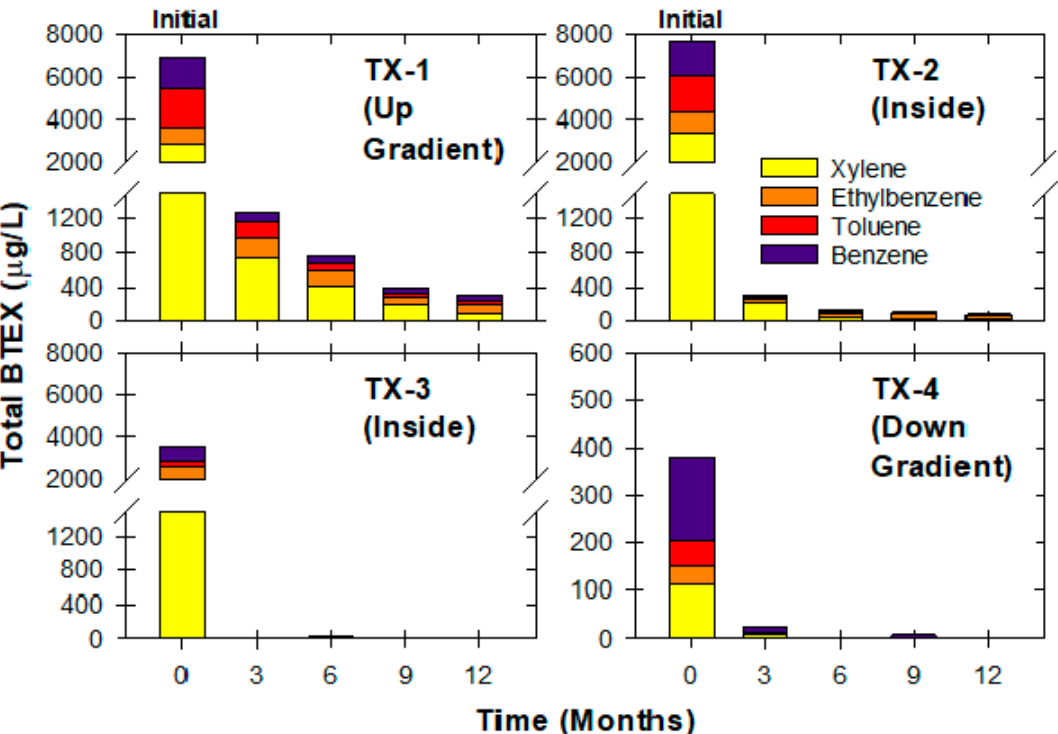
Figure 7. Changes in BTEX concentrations ( µ g L − 1 ) following treatment with reloadable direct-push aerated oxidant candles at the Textron site.